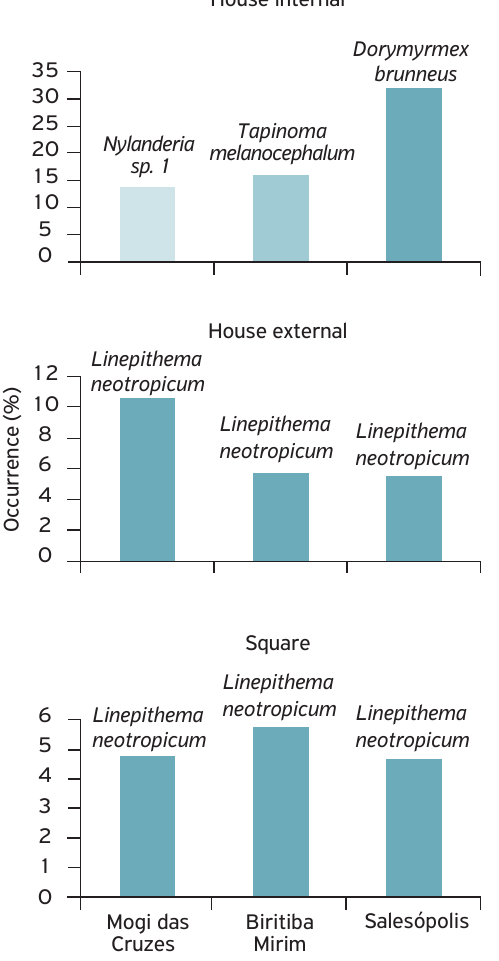
Figure 2. Most common ant species according to the municipality and collection site in the urban centers of